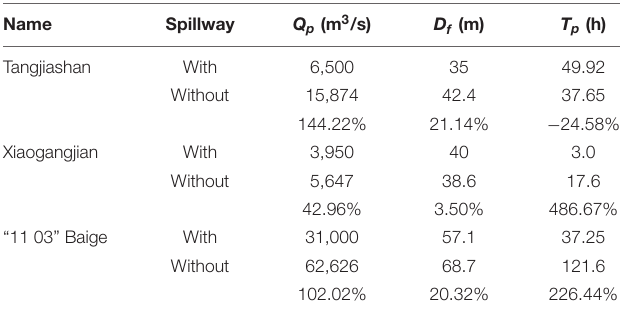
TABLE 8 | Comparison of landslide dam breaching parameters with and without